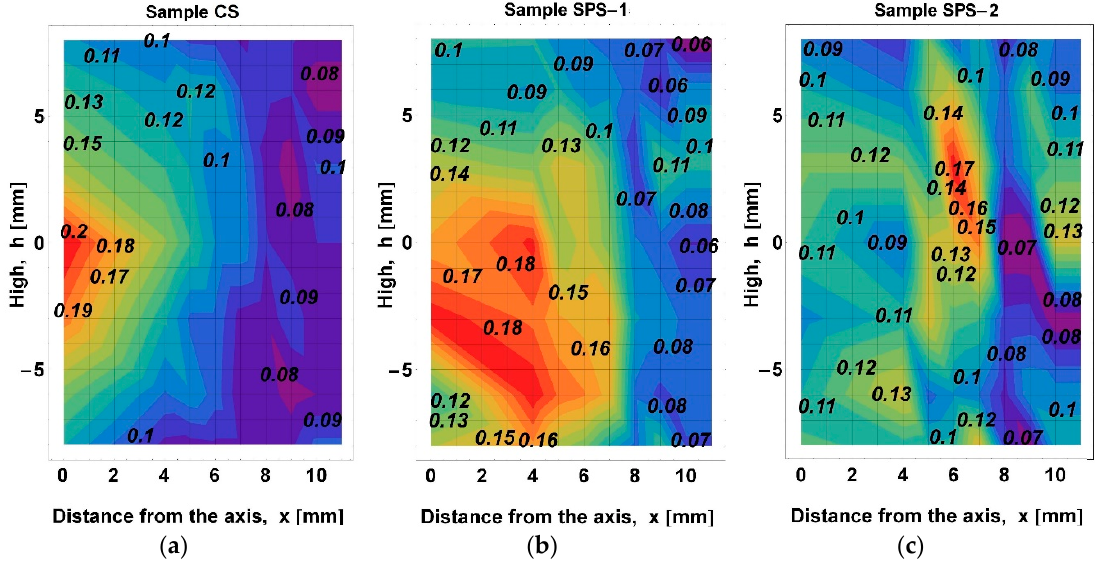
Figure 4. Porosity distribution in products sintered by ( a ) the conventional method (Sample CS), ( b ) SPS, 1120 °C, one min (Sample SPS ‐ 1), and ( c ) SPS 1050 °C, 10 min (Sample SPS ‐ 2).